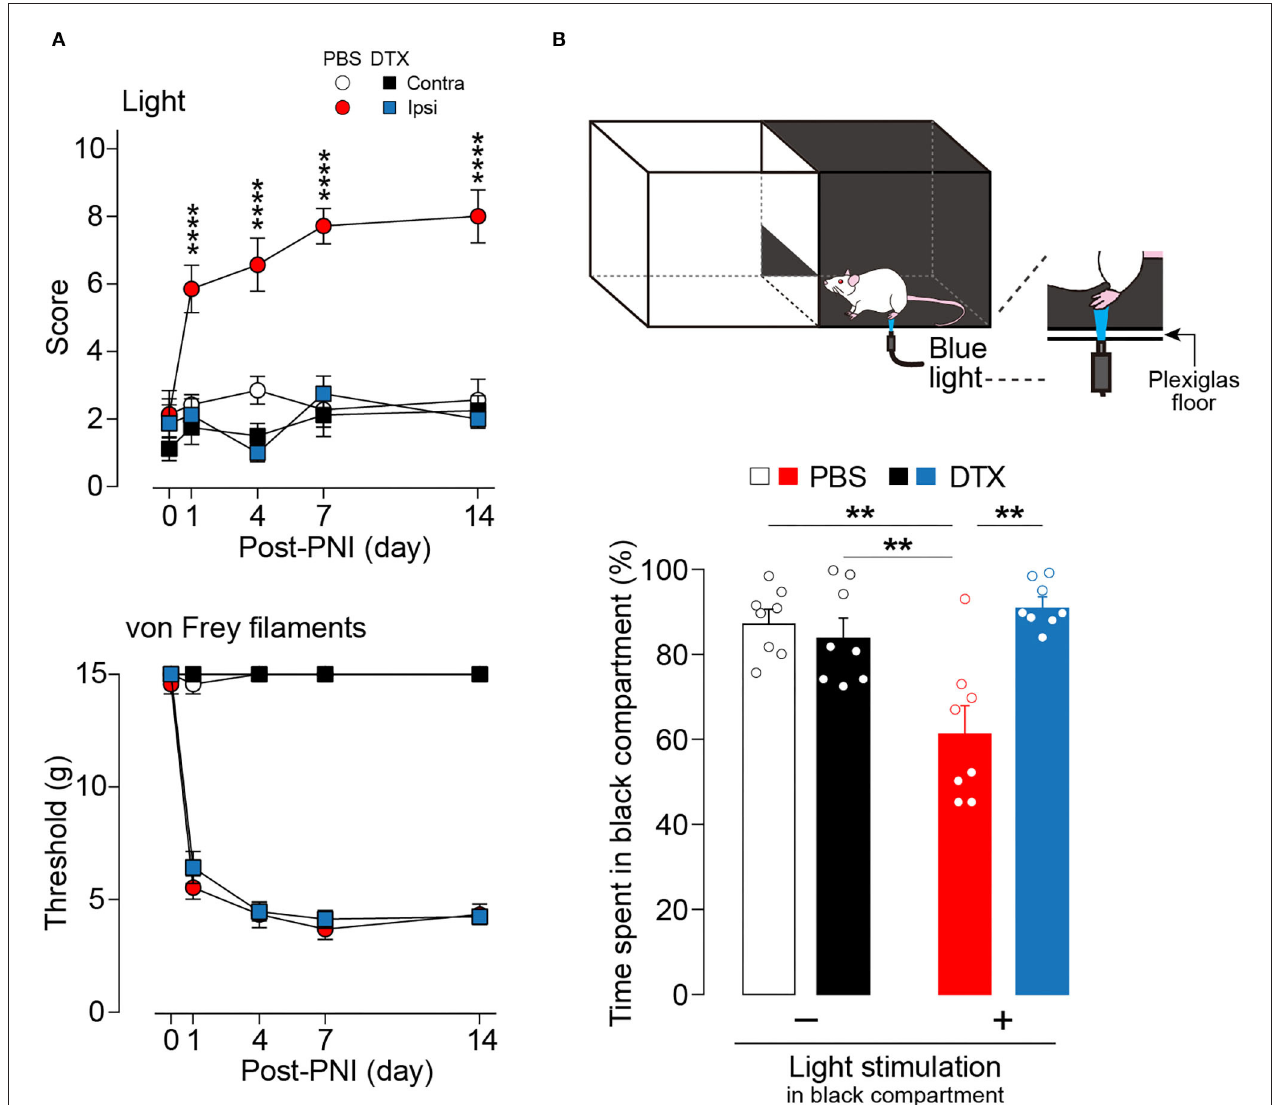
FIGURE 3 | Ablation of AAV-PdynP + spinal dorsal horn (SDH) neurons selectively attenuates optogenetic A β fiber-induced pain-like behavior after peripheral nerve injury (PNI) in rats. (A) Paw withdrawal responses to light and von Frey filaments in W-TChR2V4 rats with and without AAV-PdynP + SDH neurons after PNI ( n =